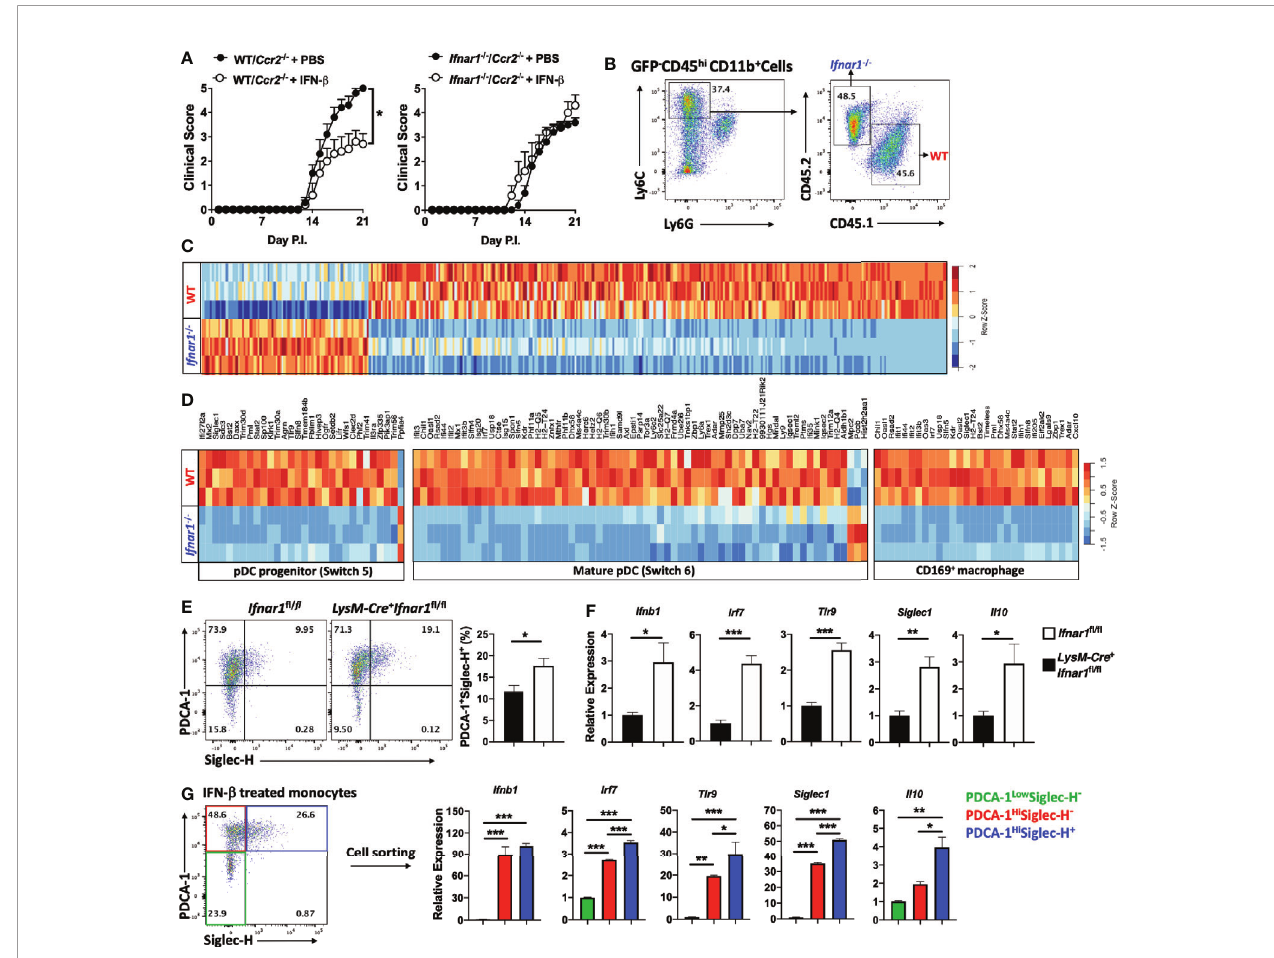
FIGURE 4 | rIFN- b suppresses EAE development by acting on monocytes. (A) To generate mixed BM chimera mice (n=5 per group), BM from WT (CD45.1) or Ifnar1 -/- mice were mixed with BM from Ccr2 -/- mice in a 1:1 ratio (total 1 x 10 7 cells) and injected into lethally irradiated WT (CD45.2) recipient mice. After seven weeks, mice were immunized for EAE induction and treated daily with i.p. injections of PBS or rIFN- b . Clinical severity scores of WT/ Ccr2 -/- and Ifnar1 -/- / Ccr2 -/- chimera mice are shown. (B) Mixed BM chimera mice were generated by transferring BM from WT (CD45.1) and Ifnar1 -/- (CD45.2) mice in a 1:1 ratio (total 1 x 10 7 cells) into lethally irradiated GFP + recipient mice (n=3). Seven weeks later, mice were immunized for EAE induction and treated with rIFN- b daily. Mice were sacri fi ced at day 15 p.i. and monocytes (CD45 hi CD11b + Ly6C hi Ly6G - ) were FACS sorted from CNS mononuclear cells. Representative fl ow cytometry dot plots showing FACS sorting strategies. (C) RNA from WT and Ifnar1 -/- monocytes (n=3 per group) was extracted and analyzed by RNA-seq. Hierarchical clustering for WT and Ifnar1 -/- monocyte-speci fi c genes. (D) GSEA enrichment analysis of WT and Ifnar1 -/- monocyte-speci fi c genes in comparison with GSE114315 and SRA#SUB2908162. Heatmap showing pDC progenitor-, mature pDC- and CD169 + macrophage-speci fi c genes in rIFN- b -treated WT and Ifnar1 -/- monocytes. (E) Ifnar1 fl / fl and LysM-Cre + Ifnar1 fl / fl mice (n=5 per group) were immunized for EAE induction and treated with rIFN- b daily. Mice were sacri fi ced at day 21 p.i. and CNS-in fi ltrated monocytes were FACS sorted for fl ow cytometry and gene expression analysis. Representative fl ow cytometry dot plots showing PDCA-1 and Siglec-H expression by monocytes. Proportions (%) of PDCA-1 + Siglec-H + monocytes. (F) RNA from Ifnar1 fl / fl and LysM-Cre + Ifnar1 fl / fl monocytes was extracted and gene expression determined using RT-PCR. (G) Mice (n=3) were immunized for EAE induction and sacri fi ced at day 21 p.i. CNS mononuclear cells were isolated and cultured with MOG 35-55 and rIFN- b (1000 IU/ml) for 24 h. Monocytes were FACS sorted based on PDCA-1 and Siglec-H expression and RNA was extracted for gene expression analysis by RT-PCR. Data shown are mean ± SEM. For EAE mice, p-values were calculated using two-way ANOVA with Bonferroni ’ s multiple comparison correction. P-values were calculated using unpaired Student ’ s t -test in (E, F) , and one-way ANOVA with Bonferroni ’ s multiple comparisons test in (G) ; ***p < 0.05, **p < 0.01, ***p <